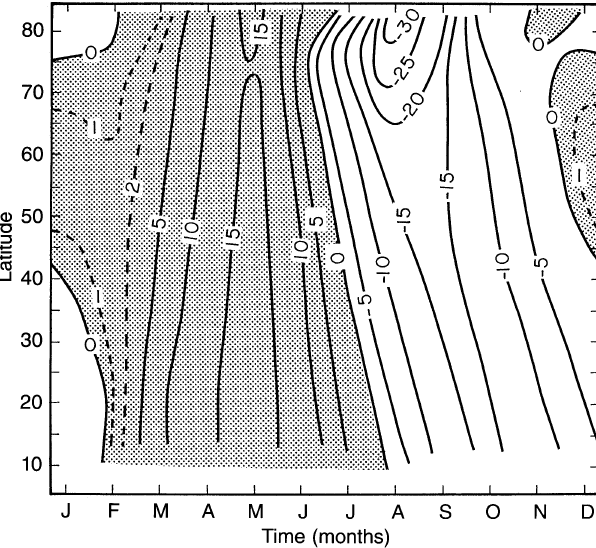
Fig. 1. The mean monthly insolation anomalies in Wm (cid:126)(cid:50) for 4 kyears AP, after